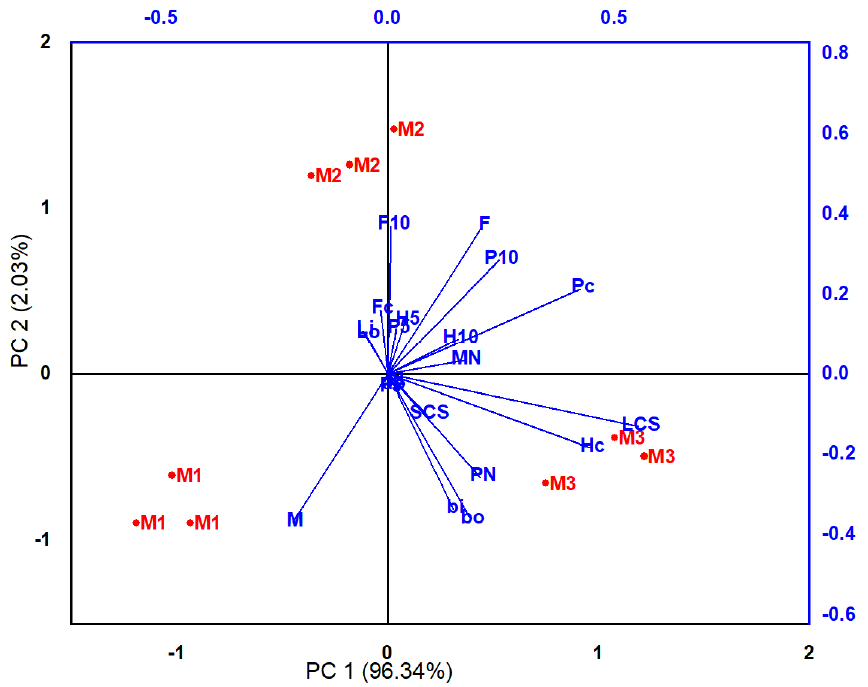
Figure 3. Principal component analysis (score and loading) of margarine samples: Lo, ao, bo-outside color parameters, Li, ai, bi-inside color parameters, F-fat content, M–moisture content, SCS-short- and middle-chain saturated fatty acids, LCS-long-chain saturated fatty acids, MN-monounsaturated fatty acids, PN-polyunsaturated fatty acids, Hc-cone penetrometer hardness, Pc-cone penetrometer plasticity, Fc-cone fracturability, H5-5 mm spherical penetrometer hardness, P5-5 mm spherical penetrometer plasticity, F5-5 mm spherical fracturability, H10-10 mm spherical penetrometer hardness, P10-10 mm spherical penetrometer plasticity, F10-10 mm spherical